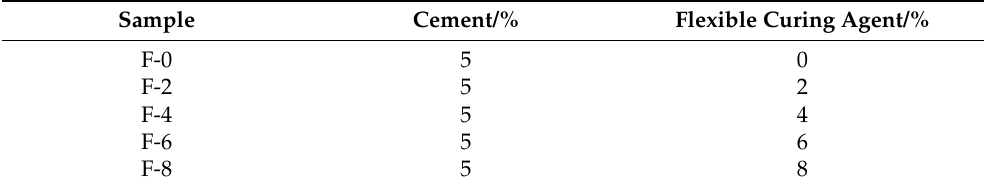
Table 5. The stabilized soil